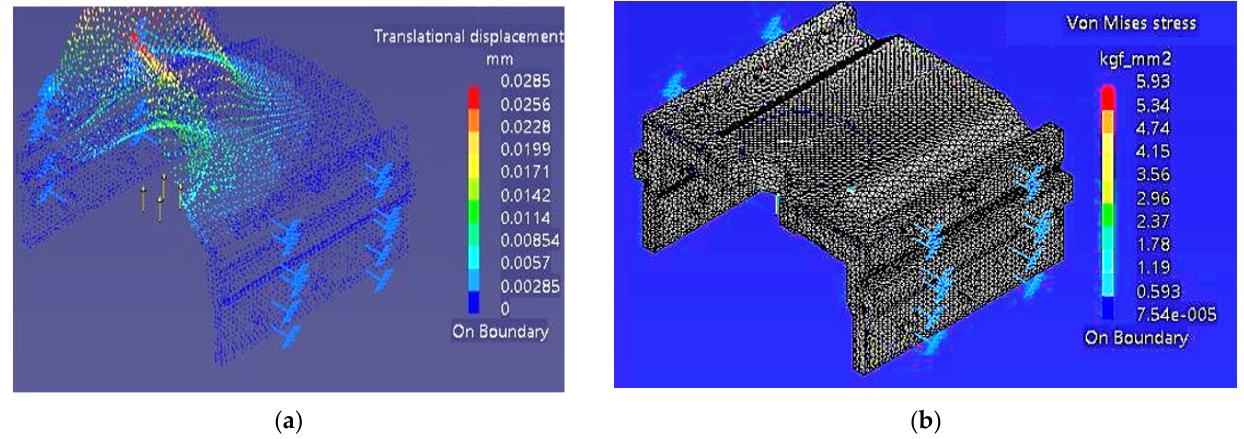
Figure 12. The deformation values ( a ) and equivalent stresses ( b ) for the trimming die with the modified active part geometry.